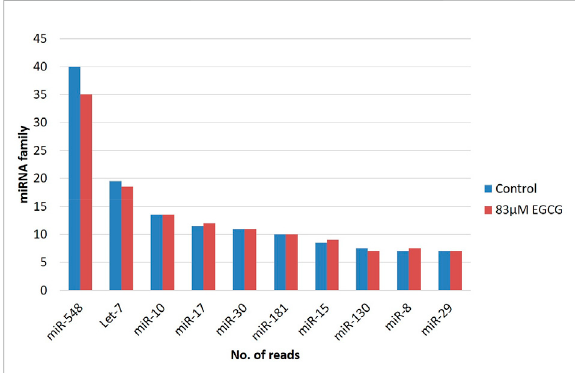
FIGURE 2 microRNA family distribution of known microRNAs in